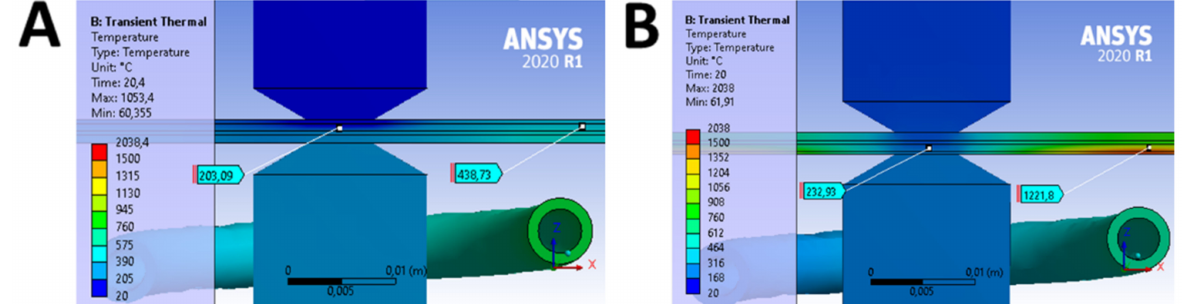
Figure 8. The results of the comparative analysis for two configurations of sheet arrangement: ( A ) solid material of the DP600 was on the side of the inductor and ( B ) MPC material was located on the side of the